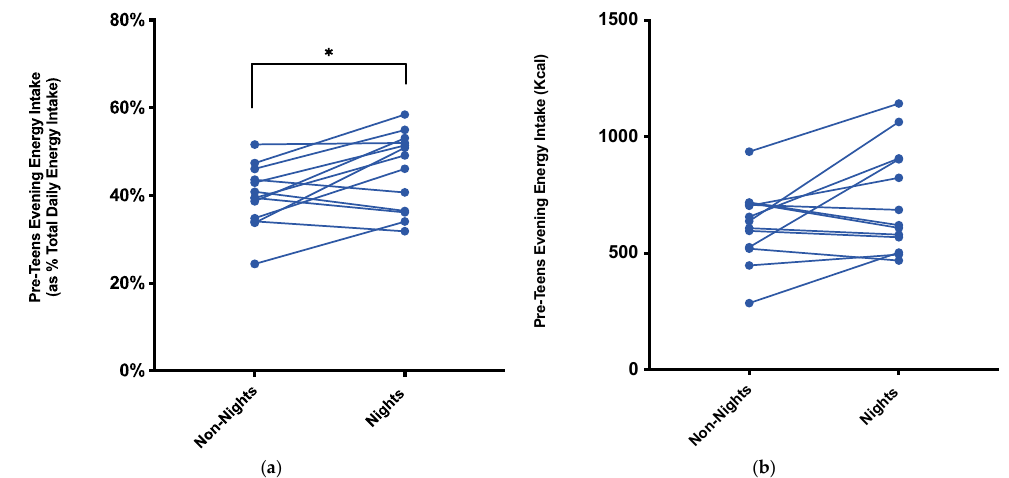
Figure 1. ( a ) The proportion (as a percentage) of total daily energy and ( b ) absolute energy consumed (kcal) by pre-teen children ( n = 13) in the evening period [16:00–23:59 h] when mothers were working nightshifts vs. not on nightshifts. * p = 0.012 for the proportion of total daily energy consumed during the nightshift condition compared to non-nightshifts (paired t